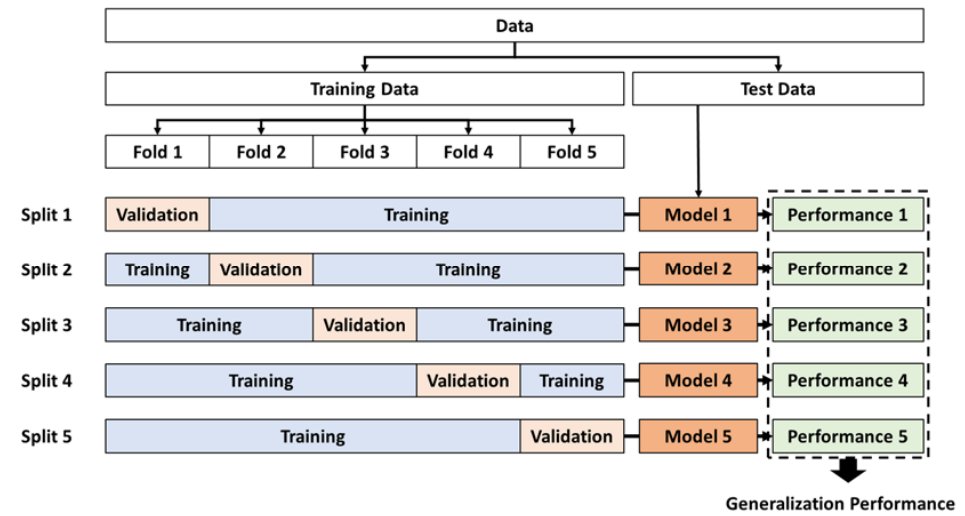
Figure 8. Diagram of five-fold cross-validation.